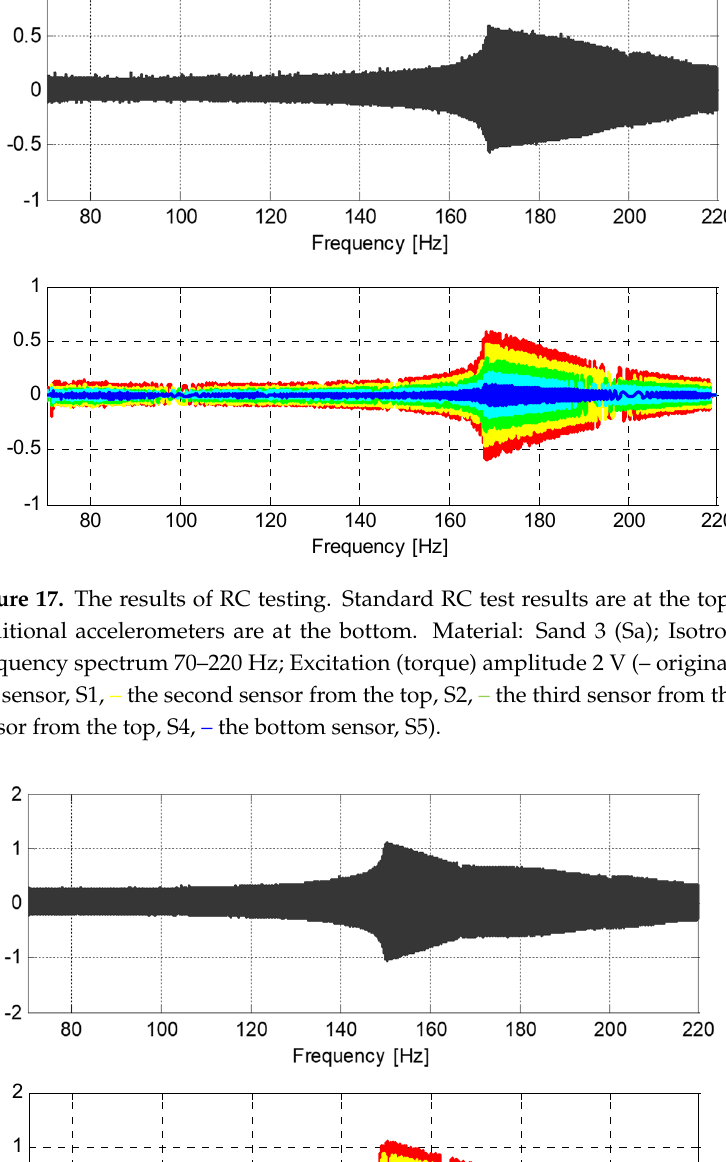
Figure 16. The results of RC testing. Standard RC test results are at the top; the results from the additional accelerometers are at the bottom. Material: Sand 3 (Sa); Isotropic pressure 100 kPa; Frequency spectrum 70–220 Hz; Excitation (torque) amplitude 0.5 V (– original built-in sensor, – the top sensor, S1, – the second sensor from the top, S2, – the third sensor from the top, S3, – the fourth sensor from the top, S4, – the bottom sensor, S5).